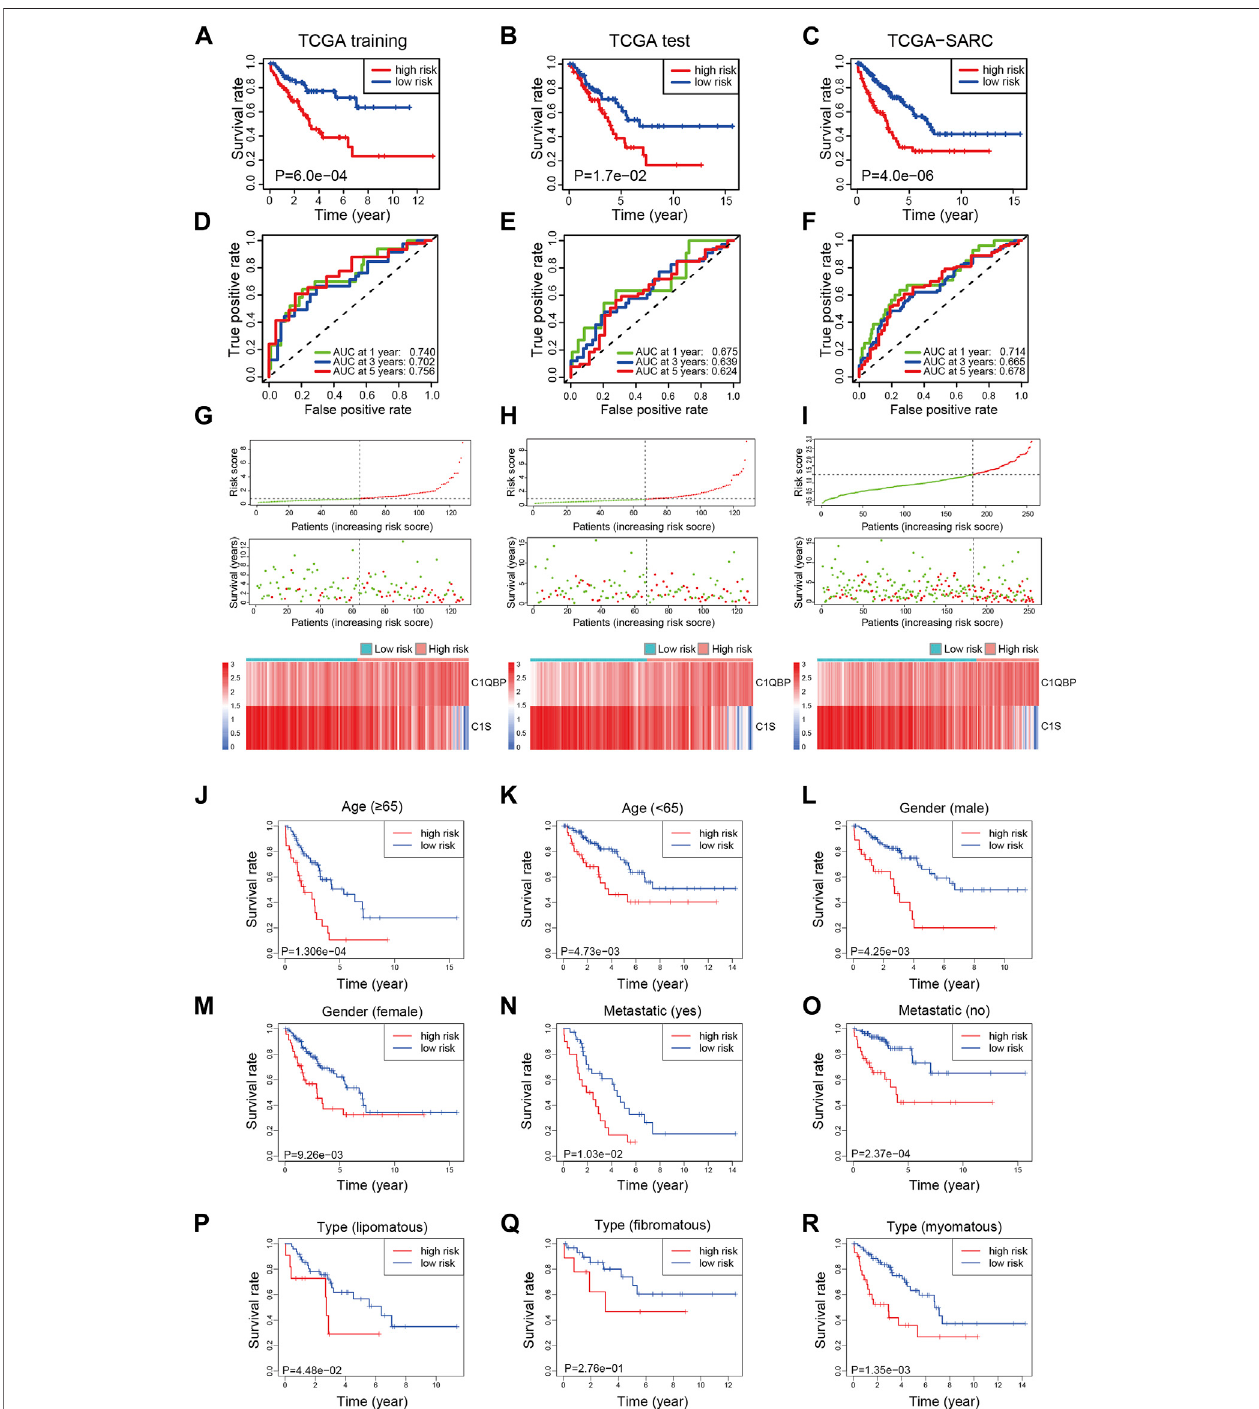
FIGURE1| Constructionofthecomplement-related genesignatureforpredictingoverallsurvivalinthetrainingsetandvalidationofitinthetestset,whole set,and differentclinical subgroupsofTCGA-SARC. The Kaplan-Meier curves estimate overallsurvivalfor the lowand high-risk groups based on the riskscore inthe training set (A) , test set (B), and whole set (C) . ROCs of complement-related genes signature for prediction of overall survival at 1, 3, and 5 years in the training set (D) , the test set (E), and the whole set (F) . The distribution of risk score, survival status, and the two-gene expression panel in the training set (G) , test set (H) , and whole set (I) . Kaplan-Meier curves estimating overall survival for the low and high risk groups based on the risk score in patients with different ages (J,K) , genders (L,M) , metastatic status (N,O) , or disease types (P – R) . TCGA, The Cancer Genome Atlas; TCGA-SARC, the whole TCGA sarcoma cohort; ROC, receiver operating characteristic curve; AUC, area under the